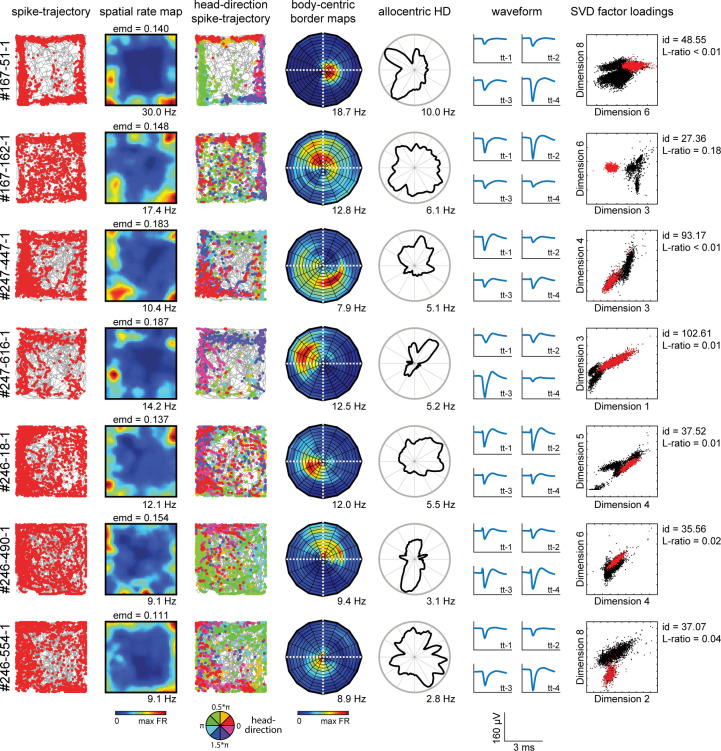
Neuron cluster properties along behavioral axes.Shown are example cells (one per row) with their firing properties across multiple behavioral variables, together with their cluster properties obtained during spike sorting. First column: trajectory spike plots with the animal’s trajectory (gray line) and his position in space (red dots) at the time of spiking. Second column: color-coded spatial rate map, with warm colors indicating higher firing rate. Third column: head-direction trajectory spike plots, with colored dots indicating the head-direction of the animal at time of spiking. Fourth column: body-centric border rate maps, showing the firing rate with respect to the distance and direction of the boundary relative to the animal. Fifth column: firing rate as a function of allocentric head-direction. Sixth column: cluster waveforms across four channels of the main tetrode. Seventh column: cluster factor loadings on two distinctive SVD factors used for cluster cutting during spike sorting in the Kilosort algorithm. Cluster quality metrics show isolation distance (id) and L-ratio (Schmitzer-Torbert et al., 2005).